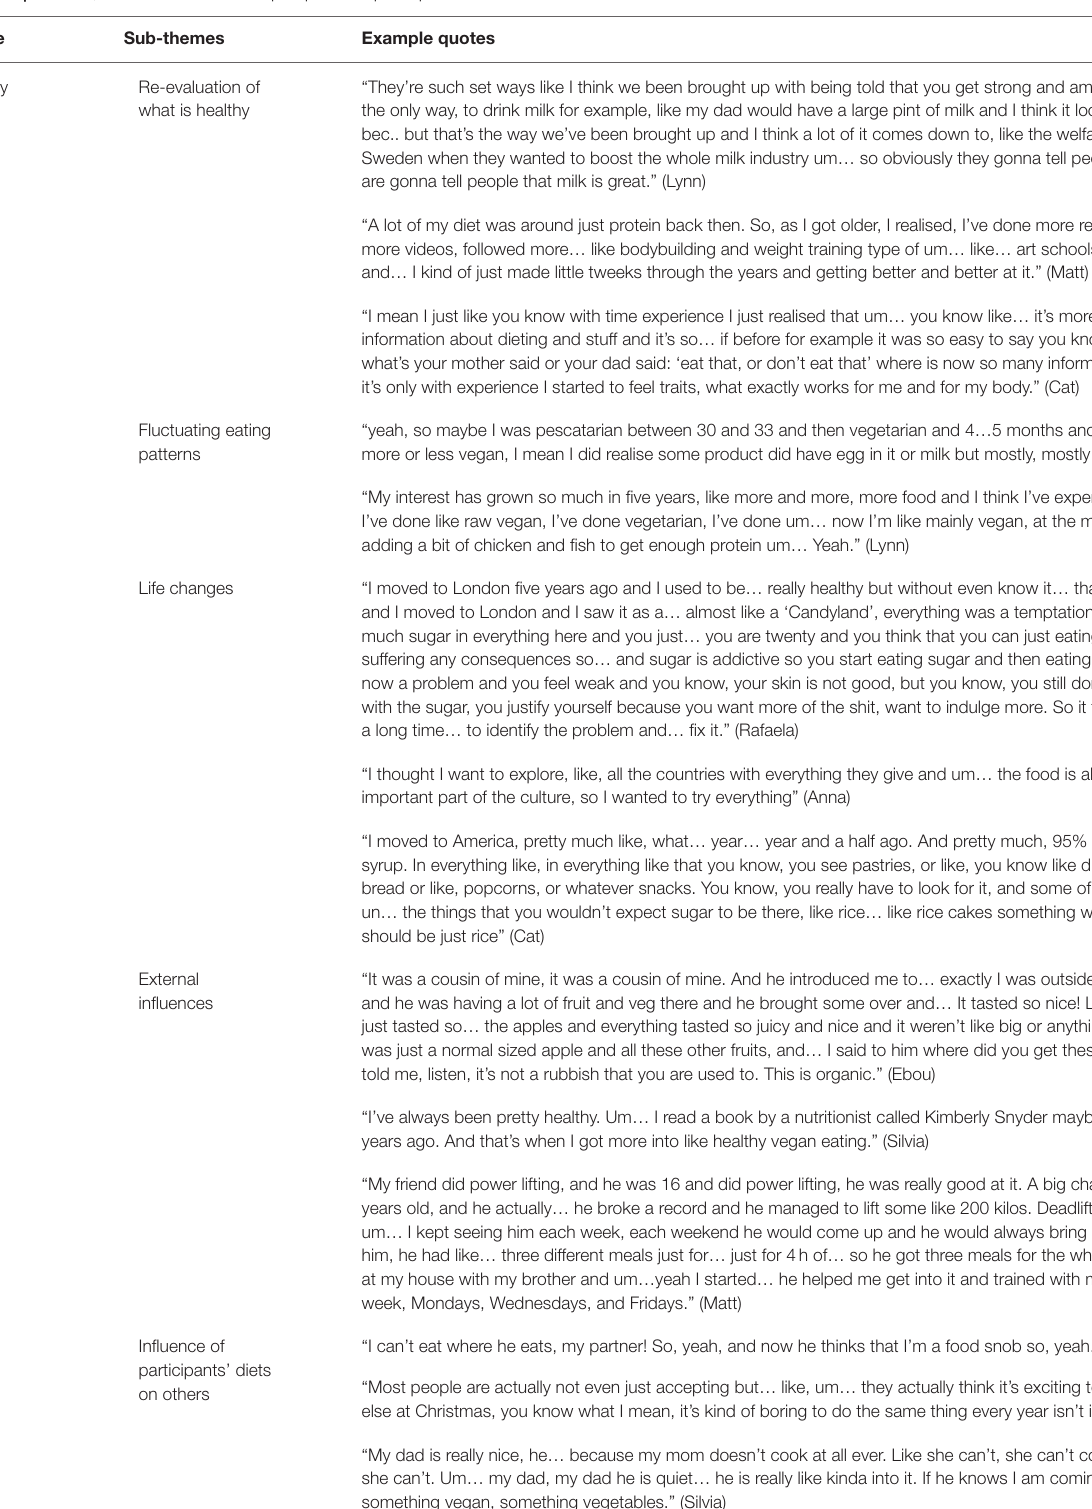
TABLE 2 | Themes, sub-themes and example quotes of participants.